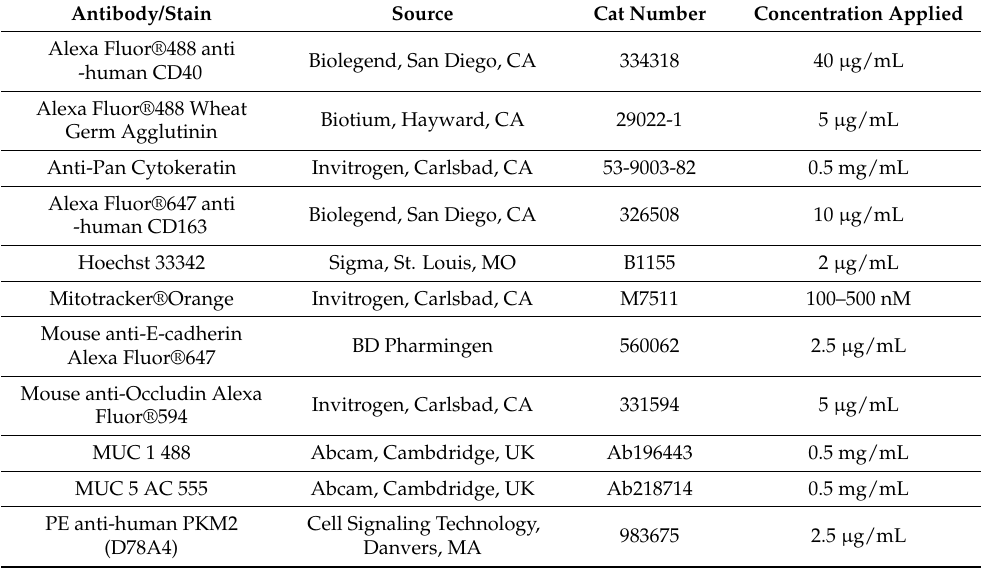
Table 1. Stains used for Confocal Imaging and Flow